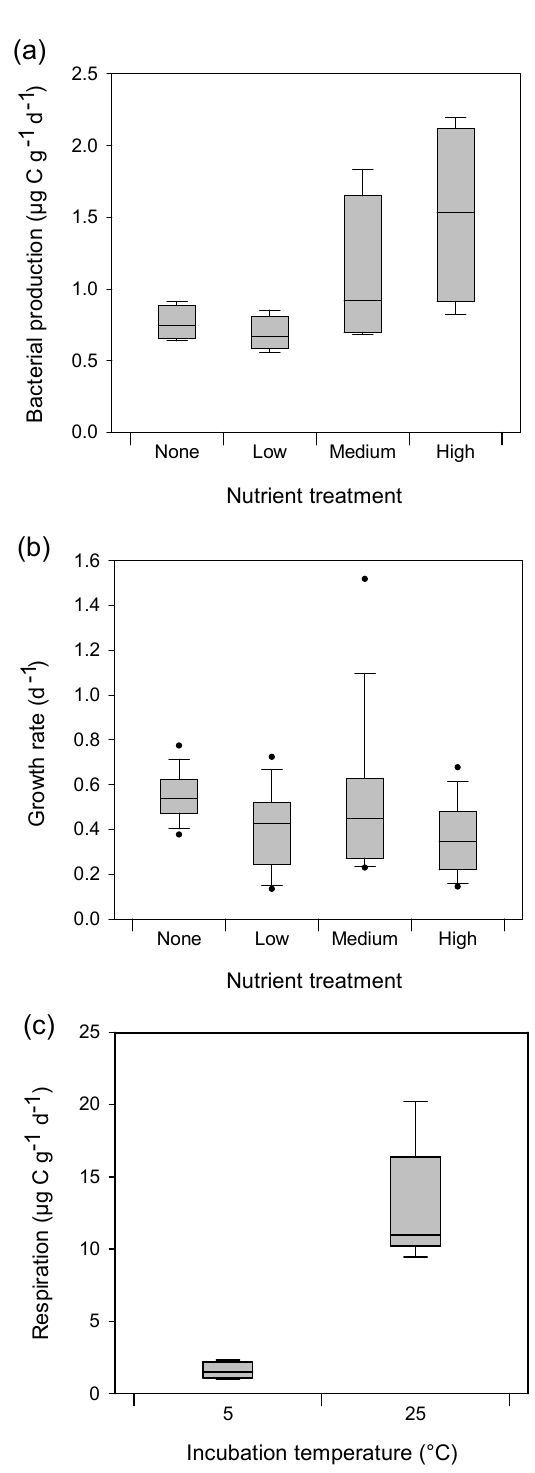
Figure 2. Measurements of (a) bacterial carbon production and (b) growth rate, derived from 3 H-leucine assays at different nutrient conditions, and (c) bacterial respiration at 5 and 25 ◦